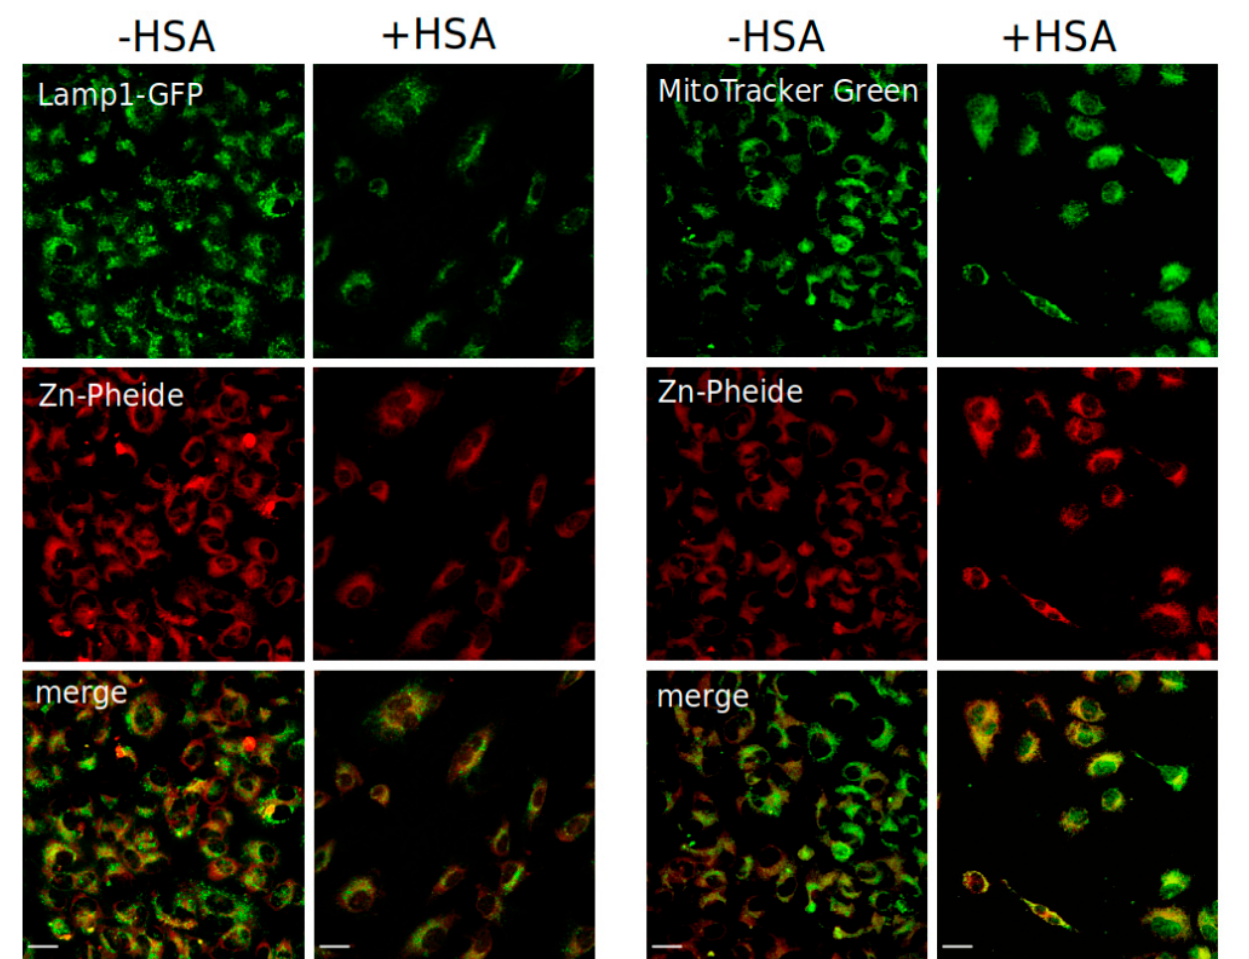
Figure 5. Colocalization analysis performed by confocal microscopy. The HUVEC cells stained with the CellLight™ Lysosomes-GFP, BacMam 2.0 reagent (fusion construct of Lamp1 and GFP) and Zn-Pheide ( left panel ), or with MitoTracker™ Green and Zn-Pheide ( right panel ), in the absence and presence of HSA. Maximum intensity projections of the representative 3D fluorescent images are shown. The scale bars represent 25 µm.